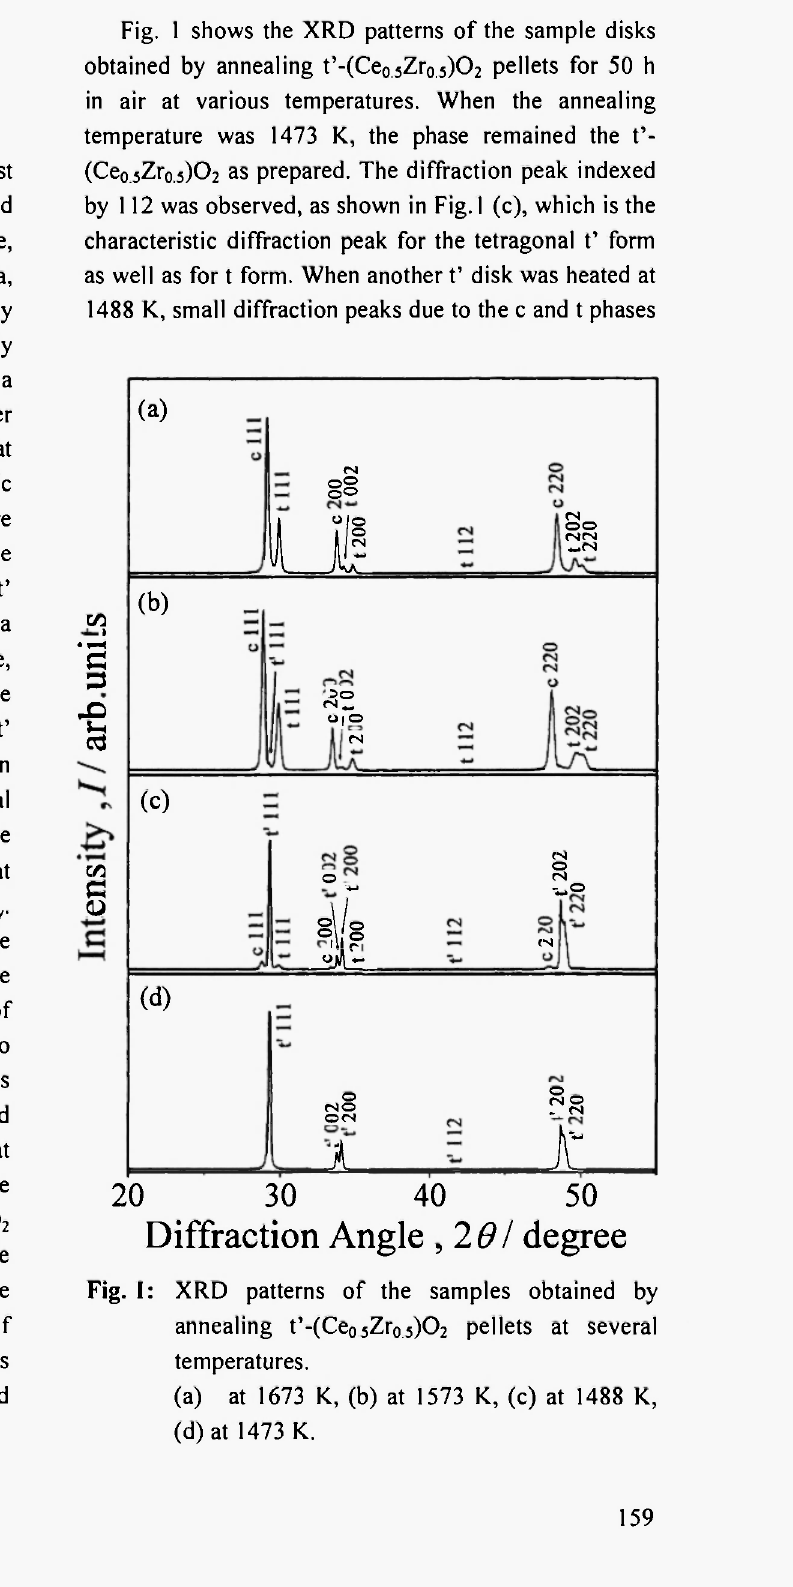
Fig. I: XRD patterns of the samples obtained